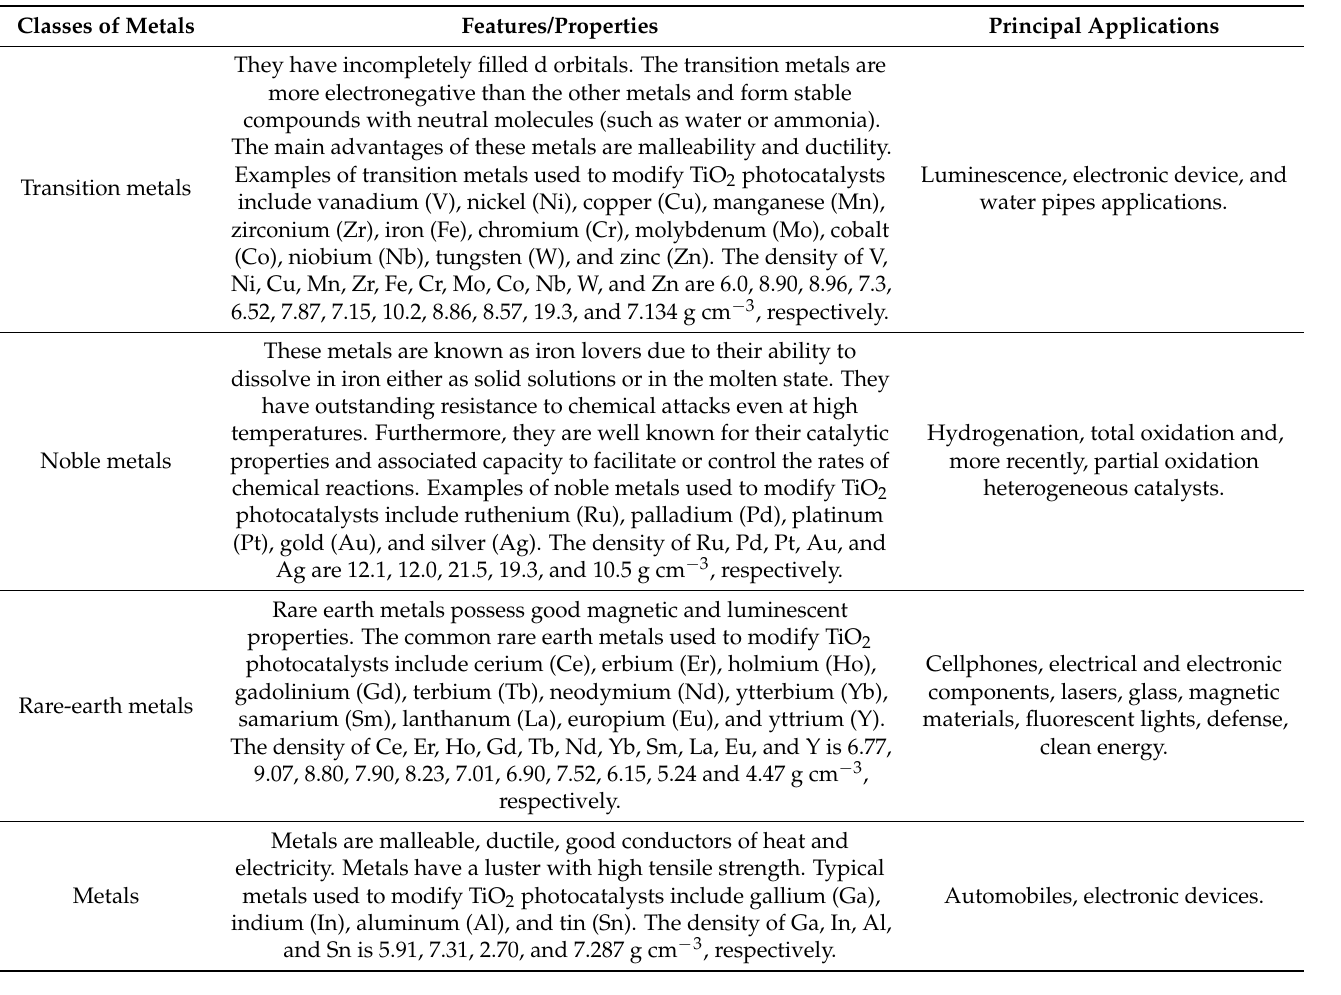
Figure 2. Table of commonly used metallic ions to enhance the photocatalytic degradation of organic pollutants. Table 2. General properties and principal applications of the